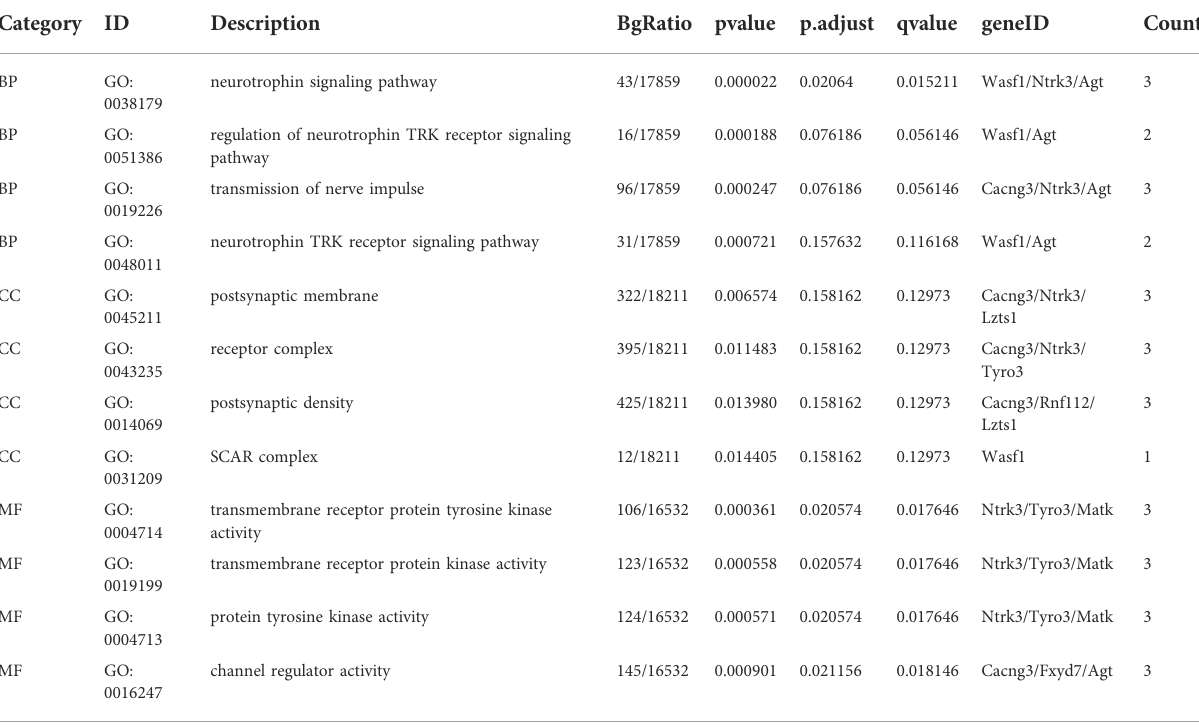
TABLE 1 GO enrichment analysis.